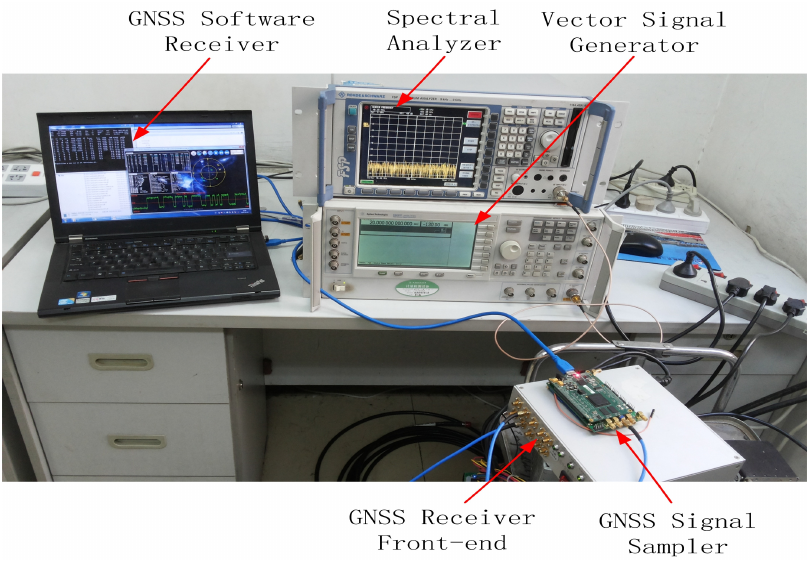
Figure 6. Experimental setup of the measurement test in the